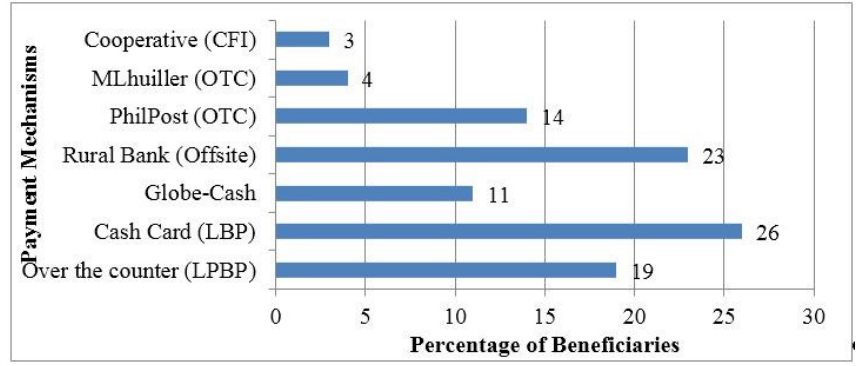
Figure 1. Percentage of beneficiaries served per payment